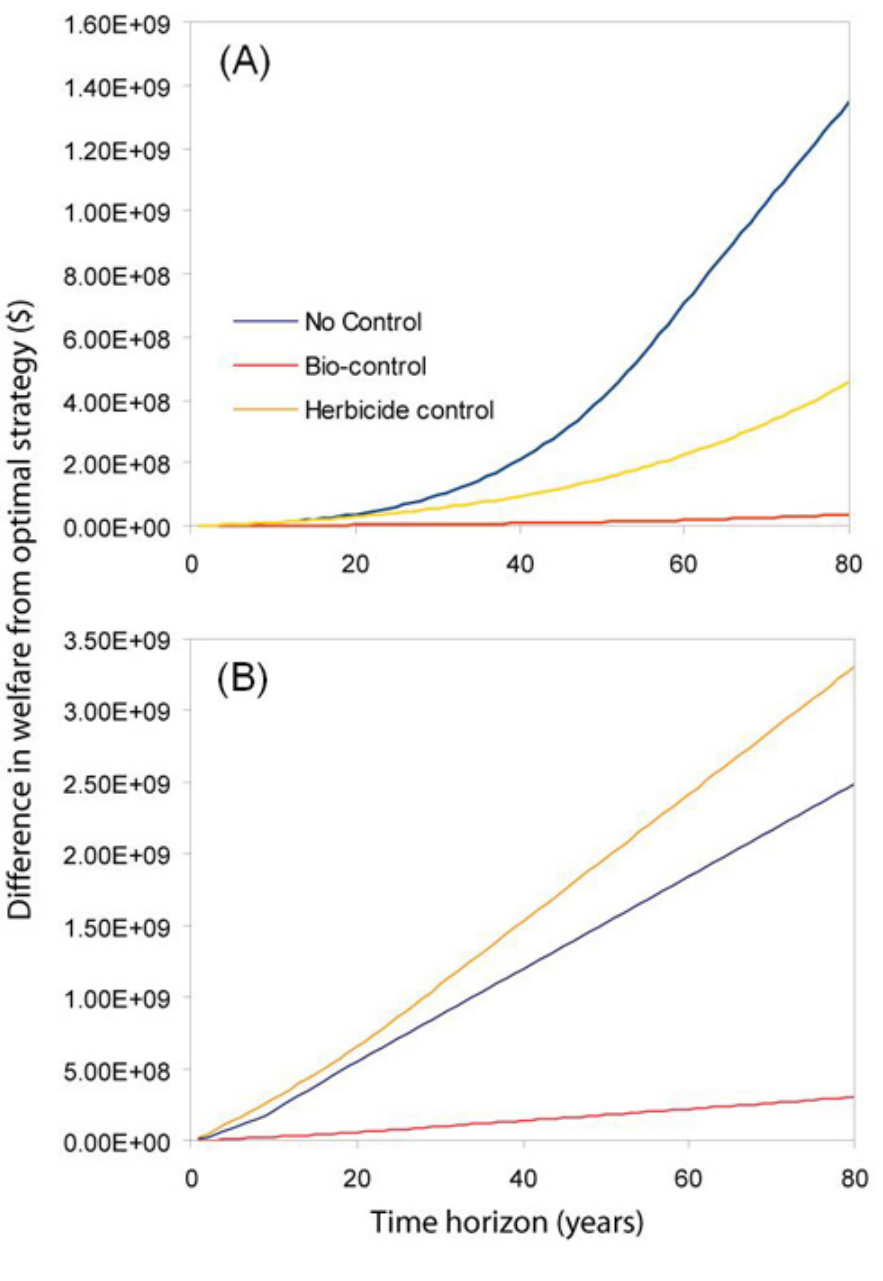
Fig. 3. Difference in welfare for the application of the optimal strategy versus the application of only one strategy (no control, biological control, or herbicide control). The cumulative welfare difference over time starting from a state with (A) a small area and low density and (B) a large area and high density of